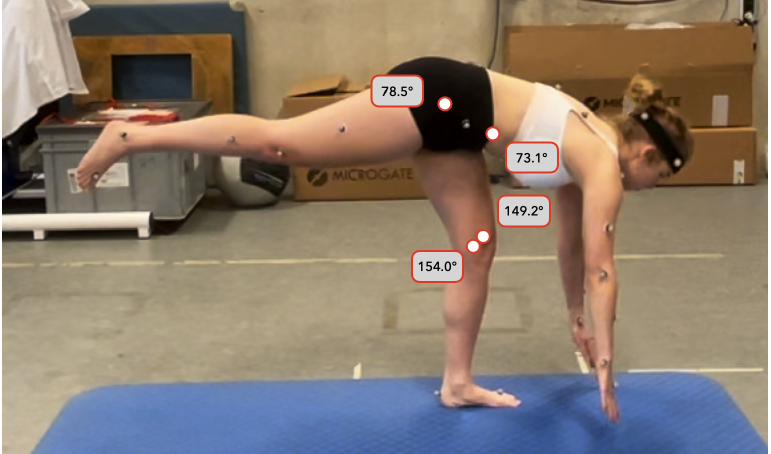
Figure 13. Exemplary screenshot of the frontal ARKit recording of one subject during the Single Leg Deadlift exercise, showing a bad detection of the hip joints and confusion of the knee